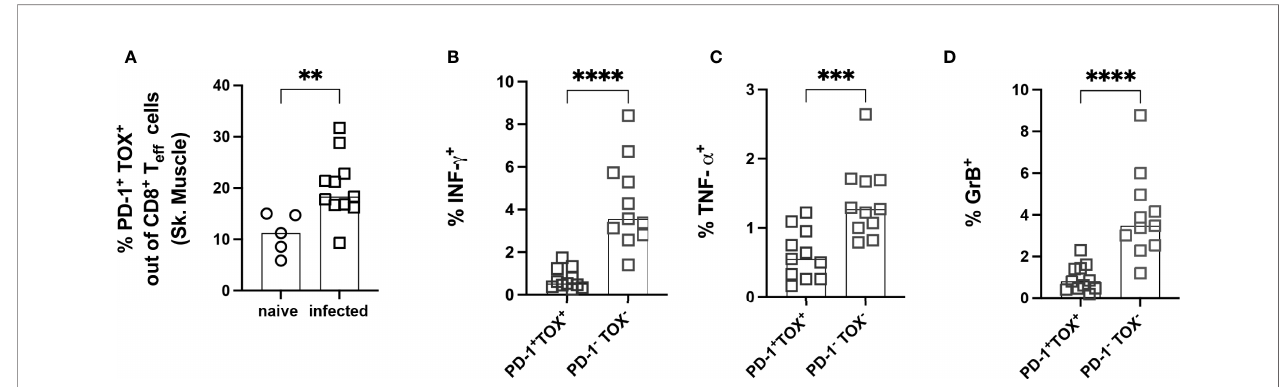
FIGURE 8 | Effector PD-1 + CD8 + T cells co-express the transcription factor TOX and show a reduced capacity to produce cytokines after ex vivo stimulation. Functional analysis of PD-1 + TOX + CD8 + T eff from muscle tissue. Representative staining for the co-expression of PD-1 and TOX on CD8 + T eff cells is depicted in Supplementary Figure 5B . (A) Co-expression of PD-1 and TOX was quanti fi ed and expressed as the frequency of CD8 + T eff cells. CD8 + T eff cells were stimulated with T. cruzi lysate to investigate functionality. IFN- g (B) , TNF- a (C) and GrB (D) were stained intracellularly. Data are from one experiment and were compared using the Kruskal-Wallis test and Dunn ’ s Multiple Comparison Test. The results are presented as mean (n.i. = 5, infected n= 11). **p < 0.01, ***p < 0.001, ****p <